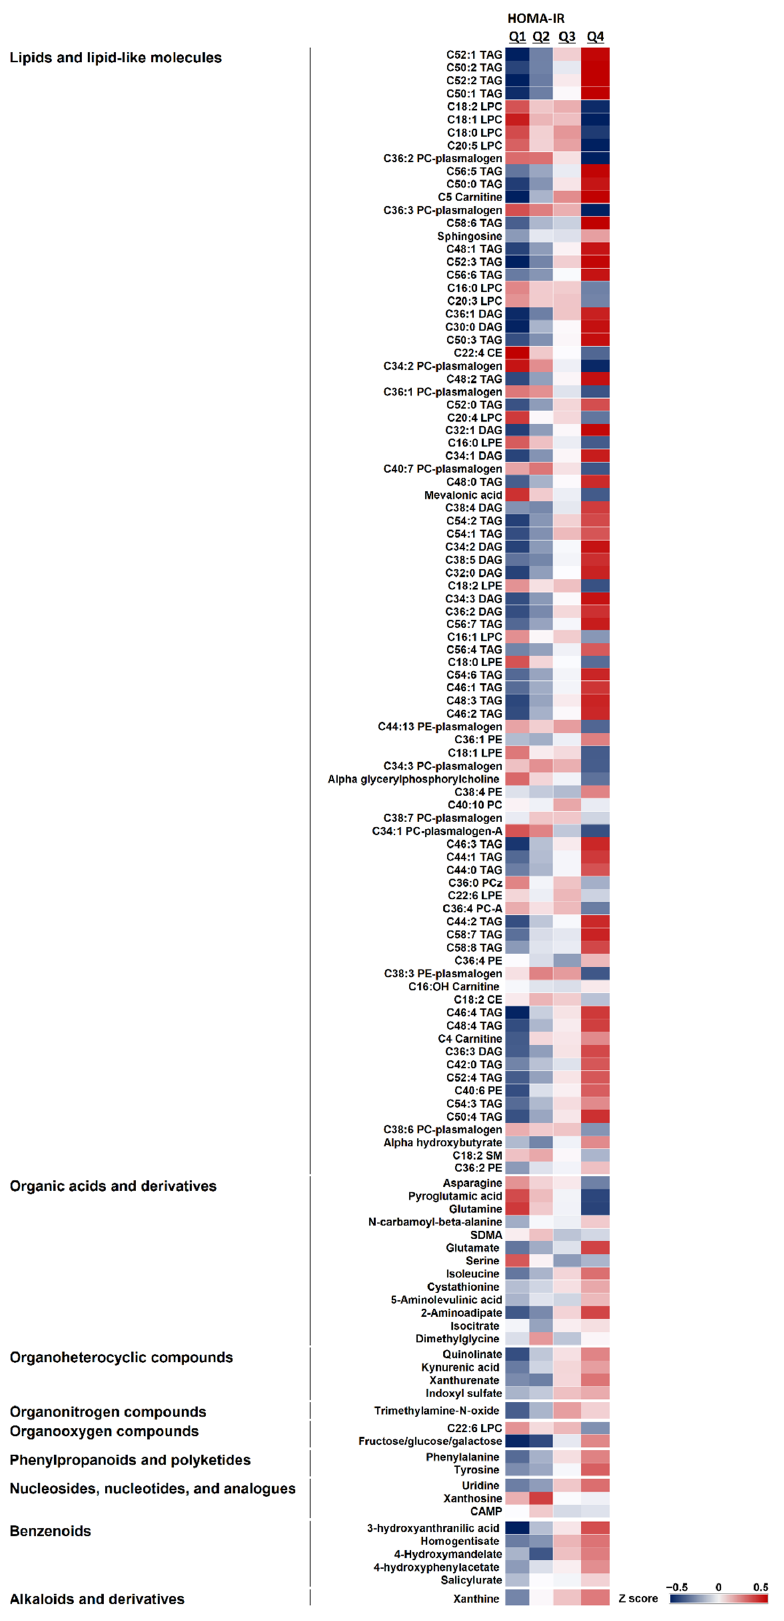
Figure 2. Representation of the 118 circulating metabolites associated with Homeostasis Model Assessment of Insulin Resistance (HOMA-IR) and their levels across HOMA-IR quartiles, after adjusting for age, weight, physical activity, medications, and smoking and accounting for multiple comparisons (false discovery rate